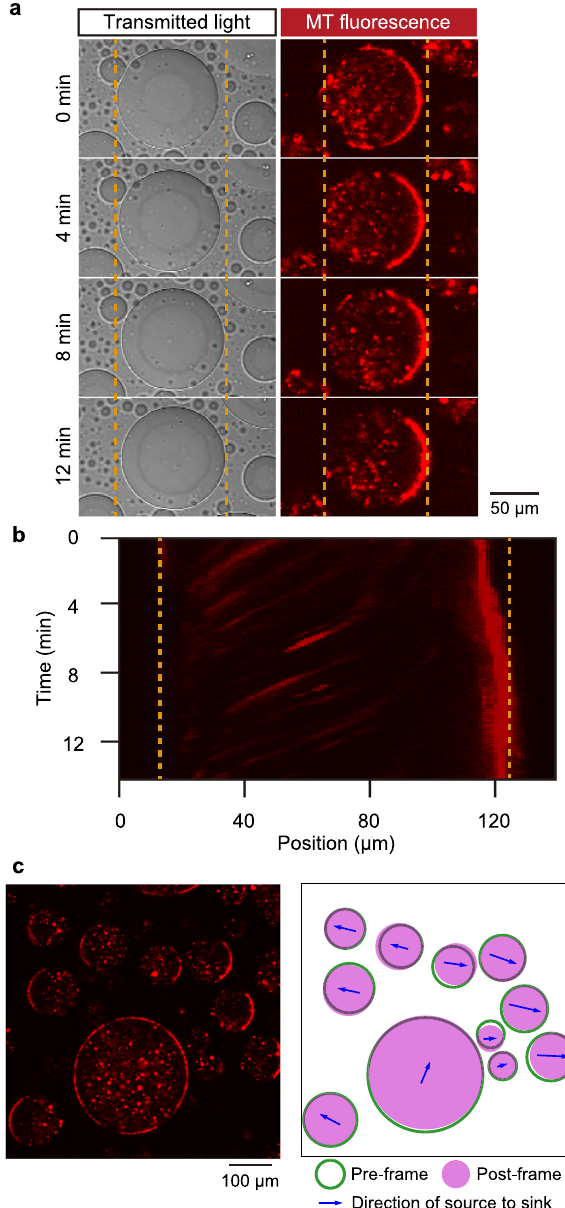
Fig. 3 Translational motion of a droplet caused by vortical fl ow inside a droplet. a Fluorescently labelled MTs are visualized in the fl uorescent image while the droplet showed translational motion in the sink direction of a pair of vortices. b Kymograph taken at the middle of the droplet shows that the speed of the droplet was on the order of 10 nm s − 1 . c The direction of the translational motion and the position of the cap-like structure at the sink part. Green coloured circle (edge) and magenta coloured circle ( fi lled) indicate the position of droplets during the pre-frame and post-frame at interval 8.5 min. Blue arrow marks show the direction of the source-to-sink point, which are obtained via image analysis of the brightness-weighted centre of each droplet. Arrow size is correlated to the distance between droplet centre and the brightness-weighted